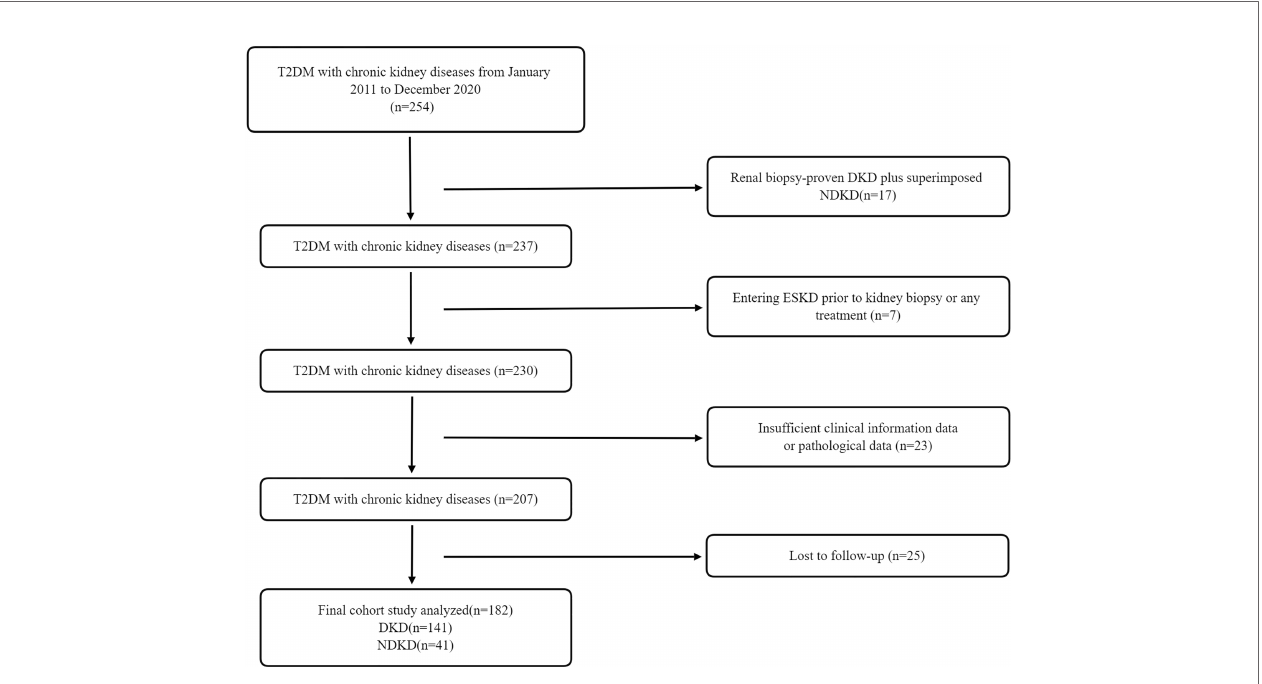
FIGURE 1 | Flowchart of study participants. T2DM, type 2 diabetes mellitus; DKD, diabetic kidney disease; NDKD, non-diabetic kidney disease; CKD, chronic kidney disease; ESKD, end-stage kidney